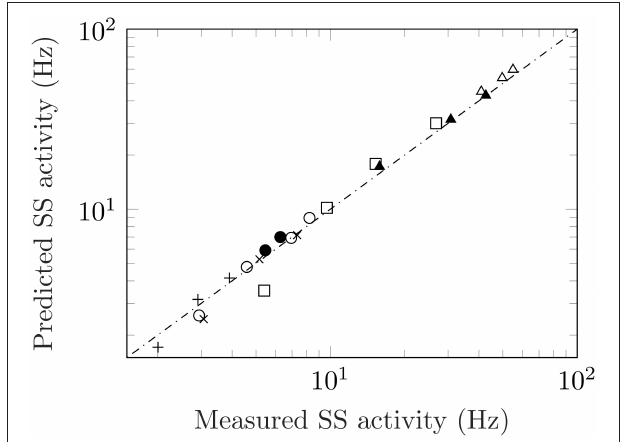
FIGURE 3 | Measured versus predicted steady-state activity for ascending and descending staircases. Data from an ascending staircase of temperatures in warm units of cats (crosses, figure 2a), Handwerker and Neher (1976) and bats (squares, figure 2), Schäfer et al. (1988); response of M1 ipRGC in mice to an ascending/descending luminance staircase (open/filled circles, figures 1b/c), Milner and Do (2017); ascending/descending staircases of acetone concentrations from olfactory sensory neurons in fruit flies which show both regular and inverted responses (open/filled triangles, figure 2c), Kim et al. (2011). Finally, the inverted responses from cold fibres to a descending temperature staircase (plusses, figure 2), Schäfer et al.